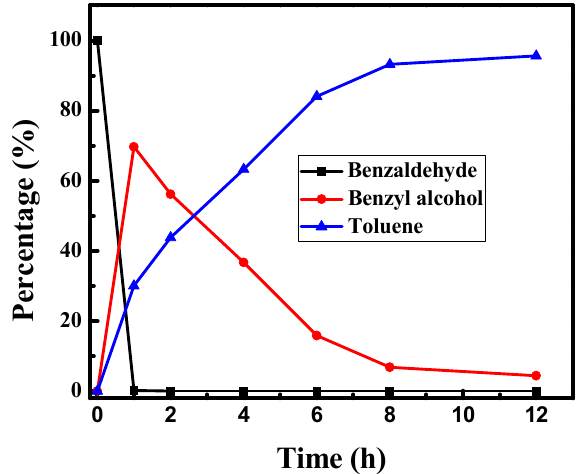
Figure 4. Time course of the deoxygenation of benzylaldehyde into toluene. Reaction conditions: benzylaldehyde (1 mmol),2 wt.% γ -Fe 2 O 3 @HAP-Pd catalyst (10 mg), H 2 O (10 mL), 2.5 bar H 2 , 70 °C.